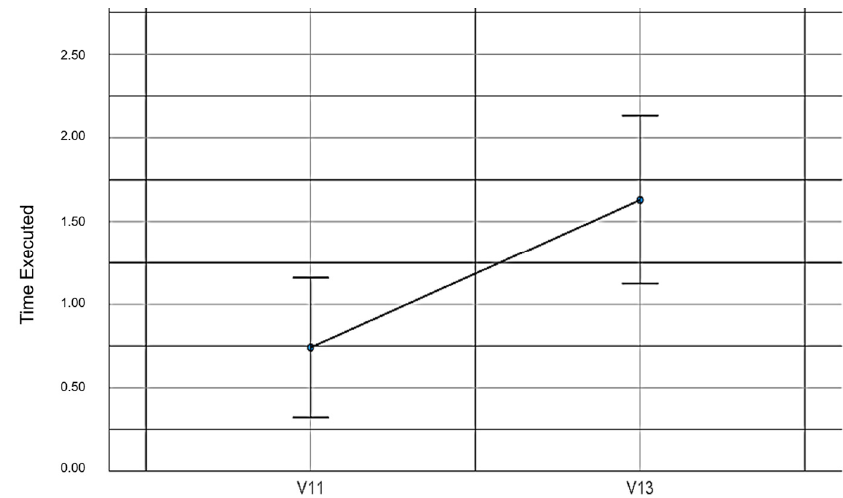
Figure 12. Errors made in the maze experiment. Figure 13 graphically represents the number of obstacles evaded under the three